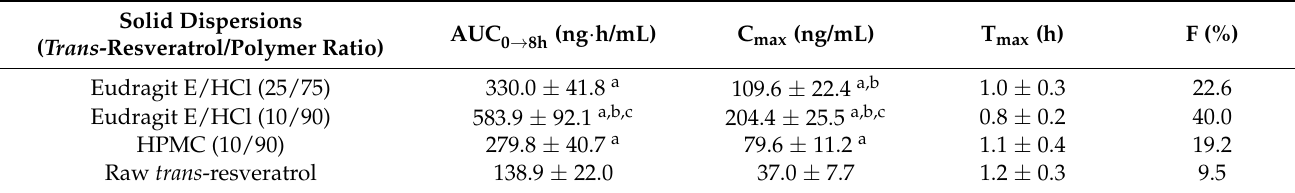
Table 2. Pharmacokinetic parameters of trans -resveratrol in rats after oral administration of raw trans -resveratrol or solid dispersions.